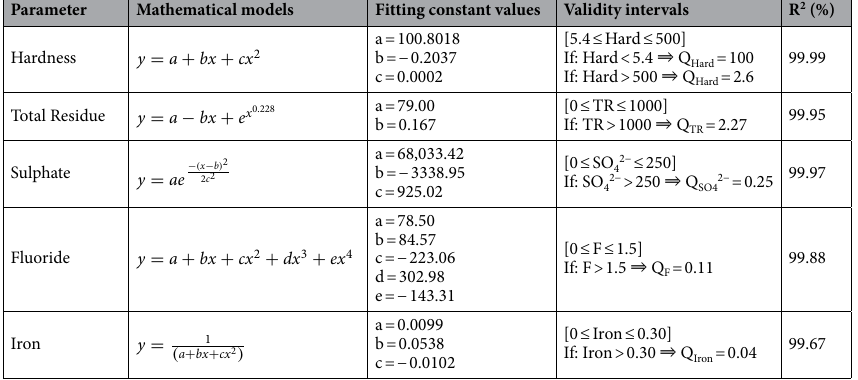
Table 8. Nonlinear fitting models for each